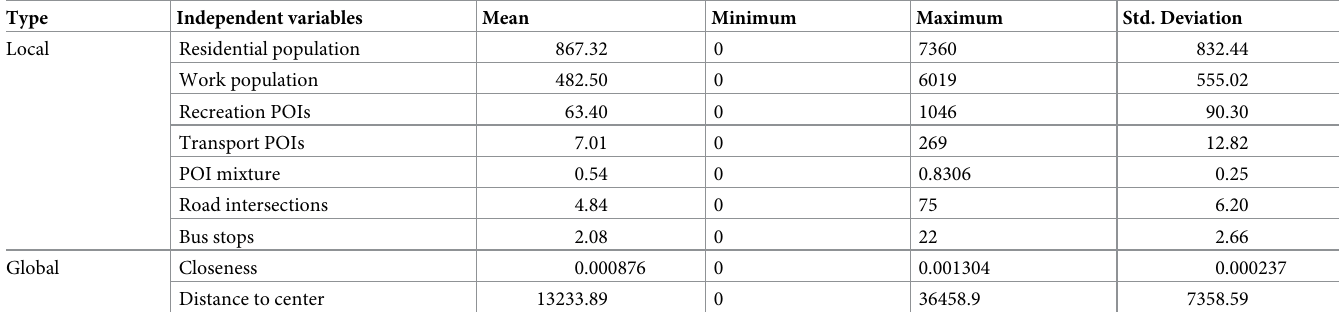
Table 1. Description of independent